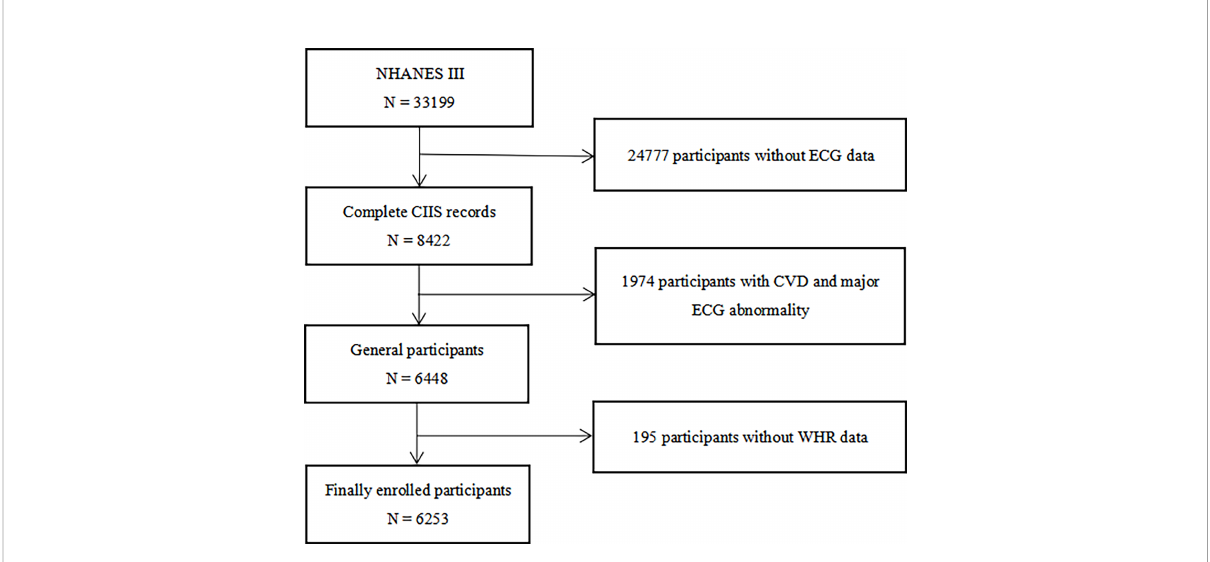
FIGURE 1 Flow chart of the study population enrollment. NHANES III the third National Health and Nutrition Examination Survey, CIIS cardiac injury/ infarction score, CVD cardiovascular disease, ECG electrocardiograph, WHR waist-hip